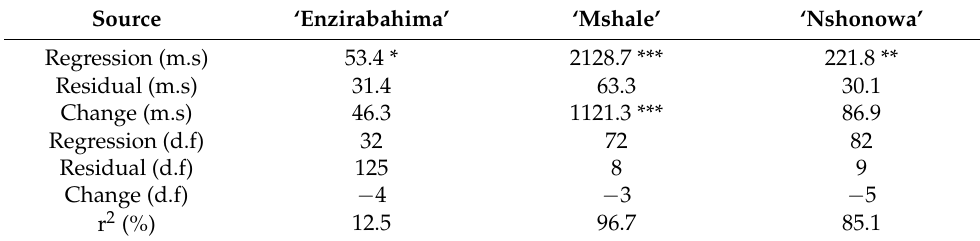
Table 6. Multiple linear regression analysis of variance mean squares of all significant weather attributes at various development stages regressed on seed set in East African Highland Cooking bananas with bunch size as the grouping factor.